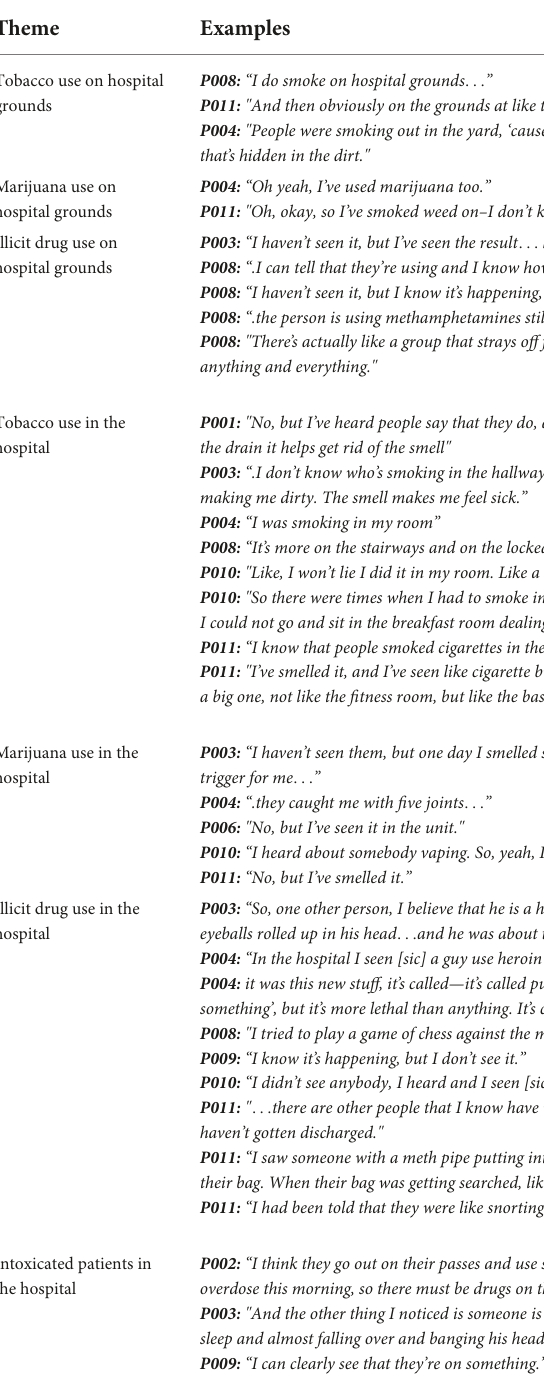
TABLE 2 Direct quotes about contraband substance use on hospital grounds and in the